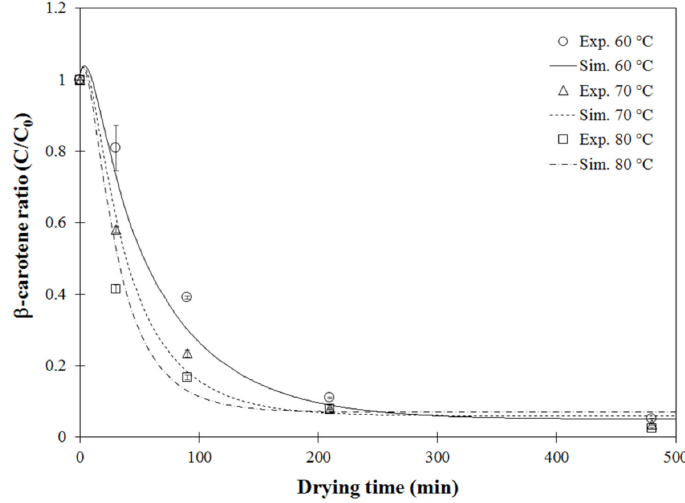
Figure 8. Validation results of β -carotene ratio of carrot cubes as a function of drying time at different drying temperatures.